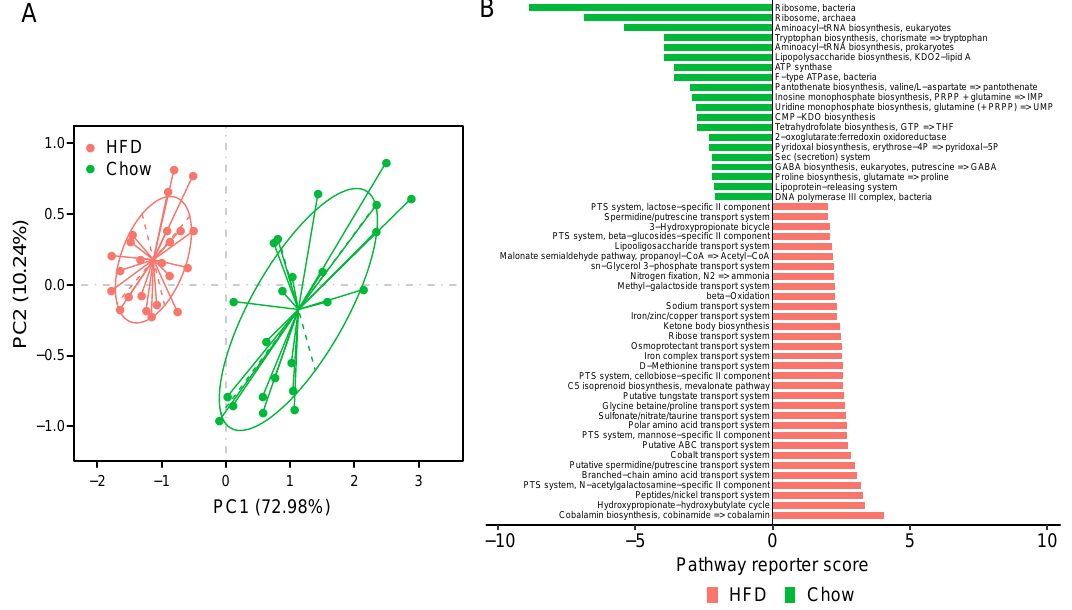
Figure 5. KOs and modules in samples of chow and HFD group. ( A ) PCA of the KO profile between the two groups. Chow samples, n = 23 (green); HFD samples, n = 23 (red). ( B ) Di ff erentially modules between chow and HFD. Reporter score ≤ − 1.96, blue color; reporter score ≥ 1.96, red